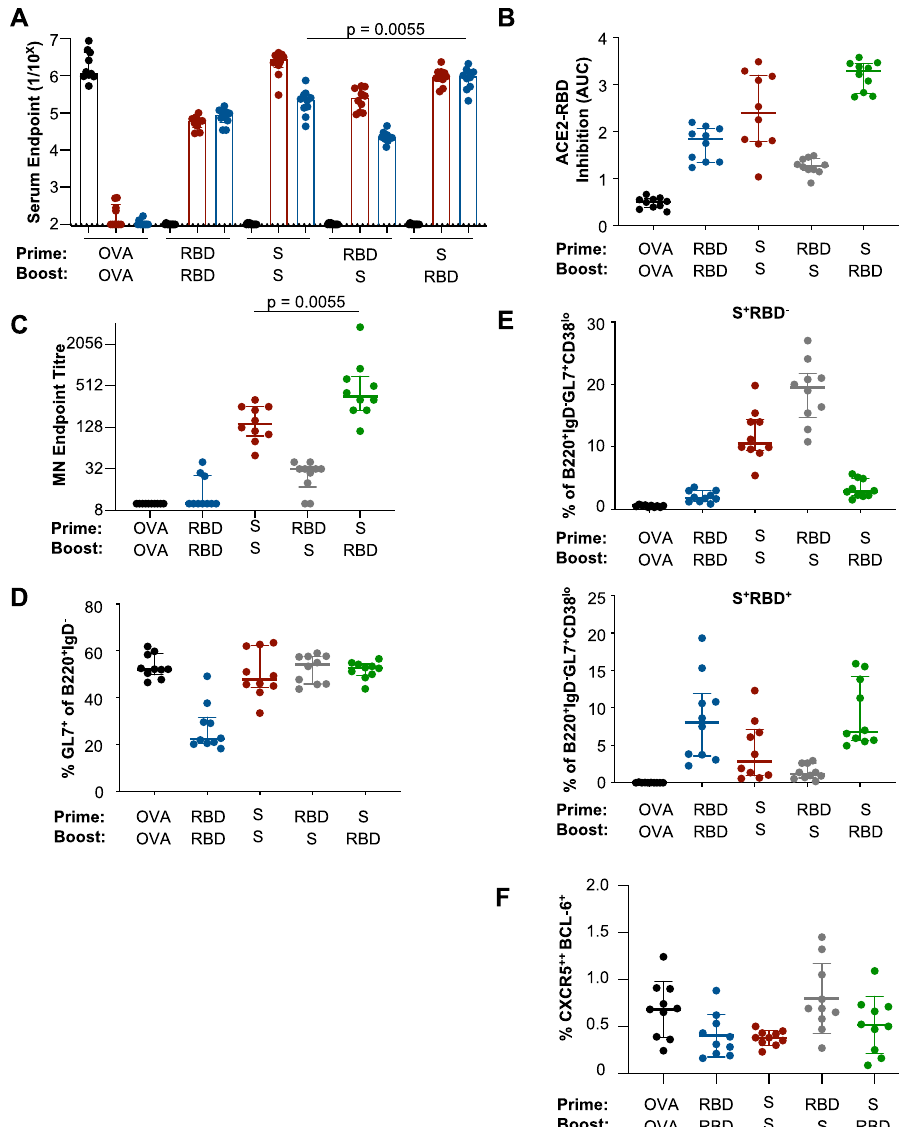
Fig. 2 Prime-boost immunisation of SARS-CoV-2 subunit proteins in C57BL/6 mice. Mice were serially immunised intramuscularly at a 21-day interval with S, RBD or OVA proteins and immune responses assessed 14 days post boost ( n = 10 animals across two independent experiments). A Reciprocal serum endpoint dilutions of S- (red), RBD- (blue) or OVA-speci fi c IgG (black) were measured by ELISA. Dotted lines denote the detection cut off (1:100 dilution). P values were derived by two-tailed Mann – Whitney U tests. B The capacity of serum antibodies to inhibit the interaction of RBD and human ACE2 was assessed by ELISA. C Neutralisation activity in the serum was assessed using a microneutralisation assay. D Draining lymph node germinal centre activity assessed by GL7 expression in B220 + IgD − B cells. E Frequency of germinal centre B cells (B220 + IgD − GL7 + CD38 lo ) speci fi c for spike (S + RBD − ) or RBD (S + RBD + ) probes. F Frequencies of TFH cells (CXCR5 ++ BCL-6 + CD4 + CD3 + B220 − ). P values were derived by two-tailed Mann – Whitney U tests. Data are presented as median ± IQR. Source data are provided as a source data fi